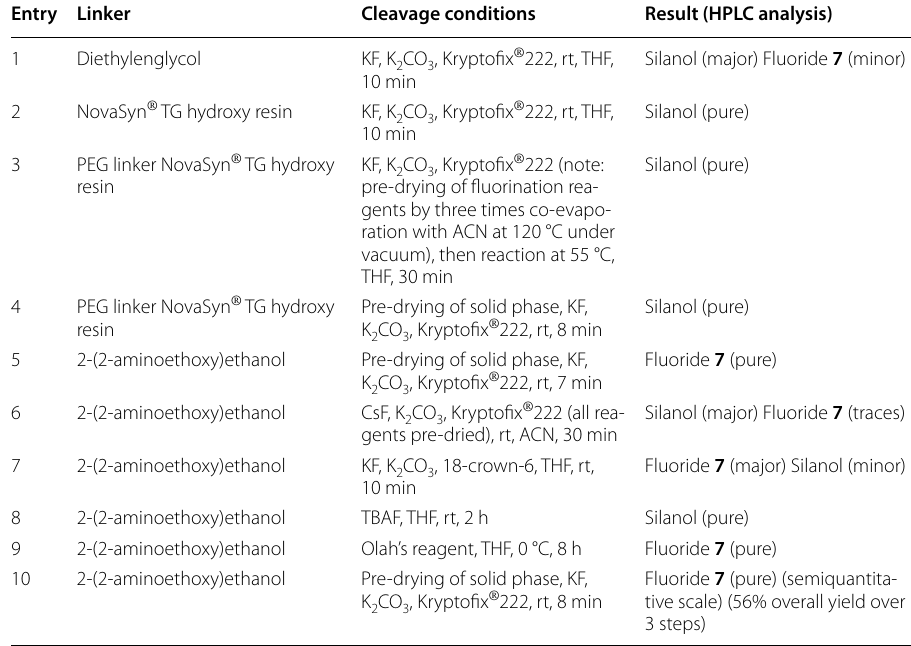
Table 1 Detagging conditions of silyl ethers 5 , 6 , and 9 Entry Linker Cleavage